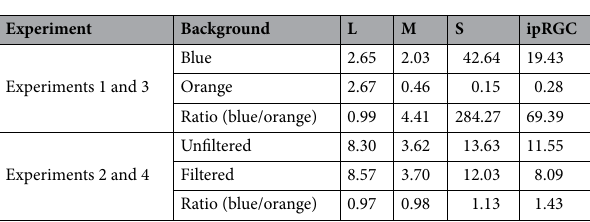
Figure 1. ( a ) The color spectra of the blue and orange backgrounds in Experiments 1 and 3. ( b ) The experimental design of Experiment 1. ( c ) Mind-wandering (MW) rate and commission error rate in Experiment 1. Error bars represent one S.E.M.